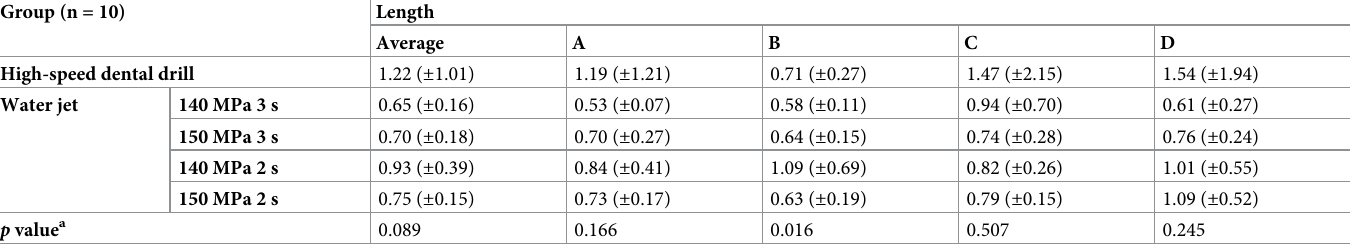
A,B,C,D represent 1/3, 2/3, 3/3 of the axial wall, pulpal wall respectively. a p values were calculated using the one-way